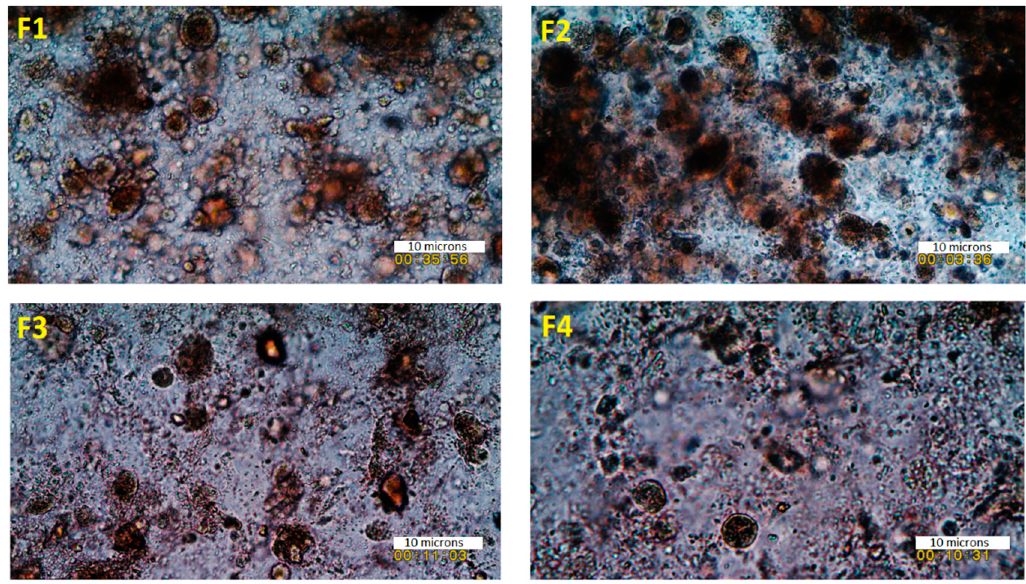
Figure 2. The texture and morphology of the semi-solid bioinks under an optical microscope of formulations F1 (F127:drug 4:1), F2 (PLA/PEG:drug 49:1), F3 (F127:drug 1:0), and F4 (PLA/PEG: drug 49:0) (scale 10 microns).